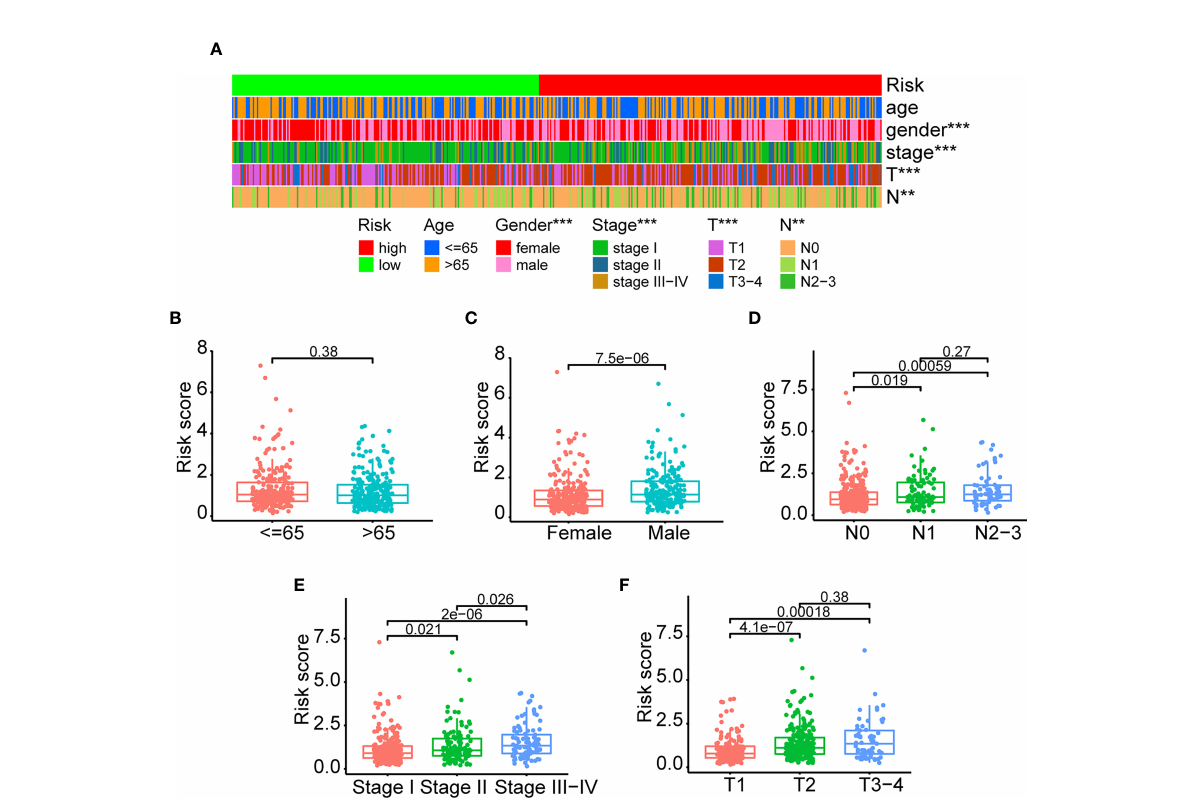
FIGURE 5 Clinicopathological association of the ERS. (A) An overview of graphs depicting the relationship between the ERS and clinical characteristics such as age, gender, stage, T-stage, and N-stage. (B – F) The risk score differences were compared among different clinical subgroups (<=65 vs >65; female vs male; stage I vs stage II vs stage III-IV; T1 vs T2 vs T3-4; N0 vs N1 vs N2-3). (**P<0.01, and